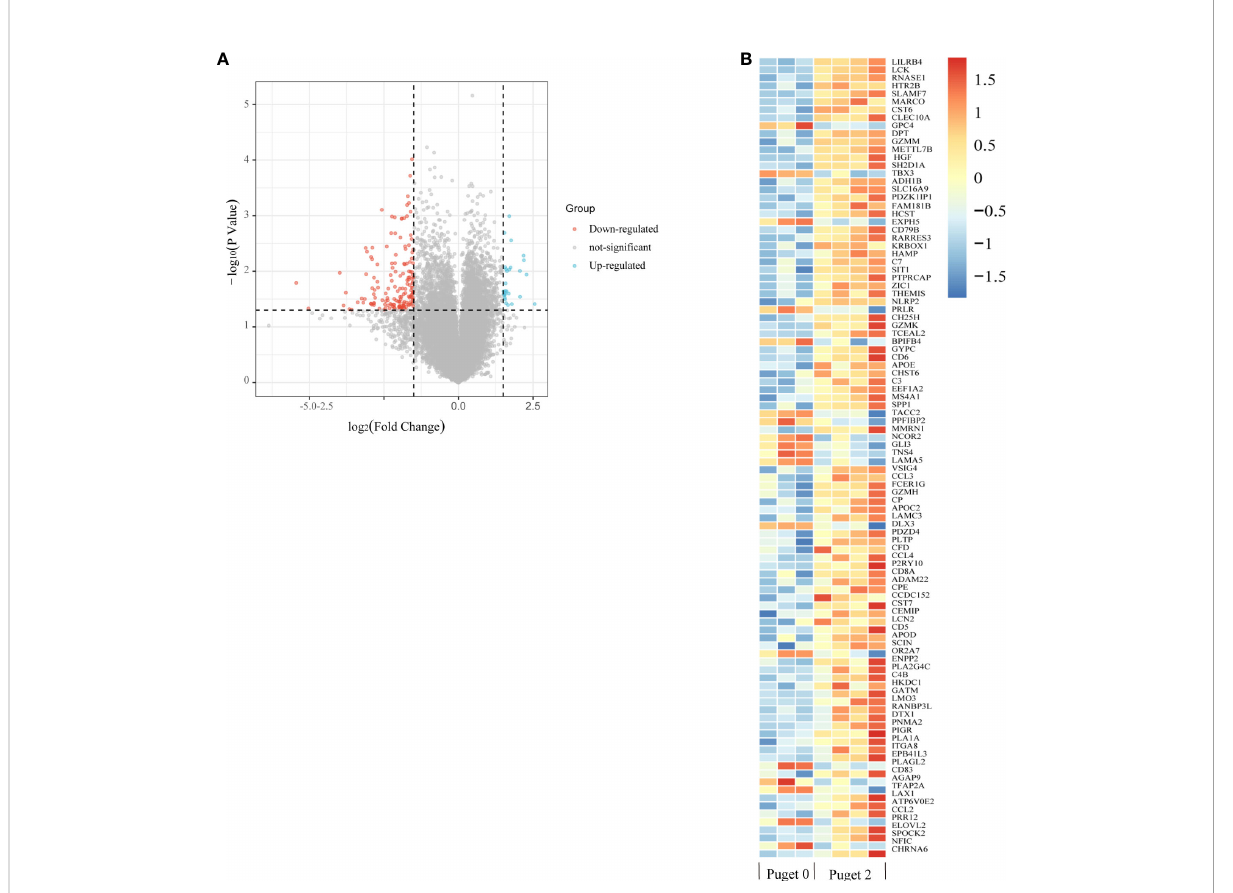
FIGURE 6 Enrichment analysis of differentially expressed genes (DEGs) related to invasiveness. (A) The volcano plot indicates DEGs between the low aggressive group (Puget grade 0, n = 3) and the high aggressive group (Puget grade 2, n = 4). Blue and red symbols classify the upregulated and downregulated genes, respectively, according to the criteria: |log2FC| > 1.5 and p-value < 0.05. (B) The heatmap summarizes the partly top differential gene expression in low and high aggressive